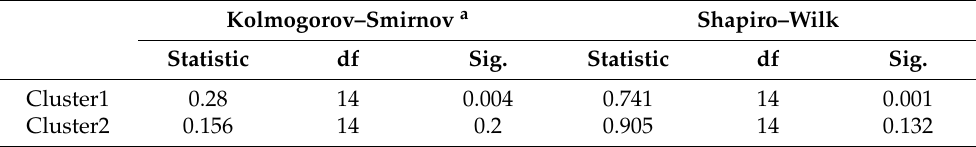
Table 4. Test of